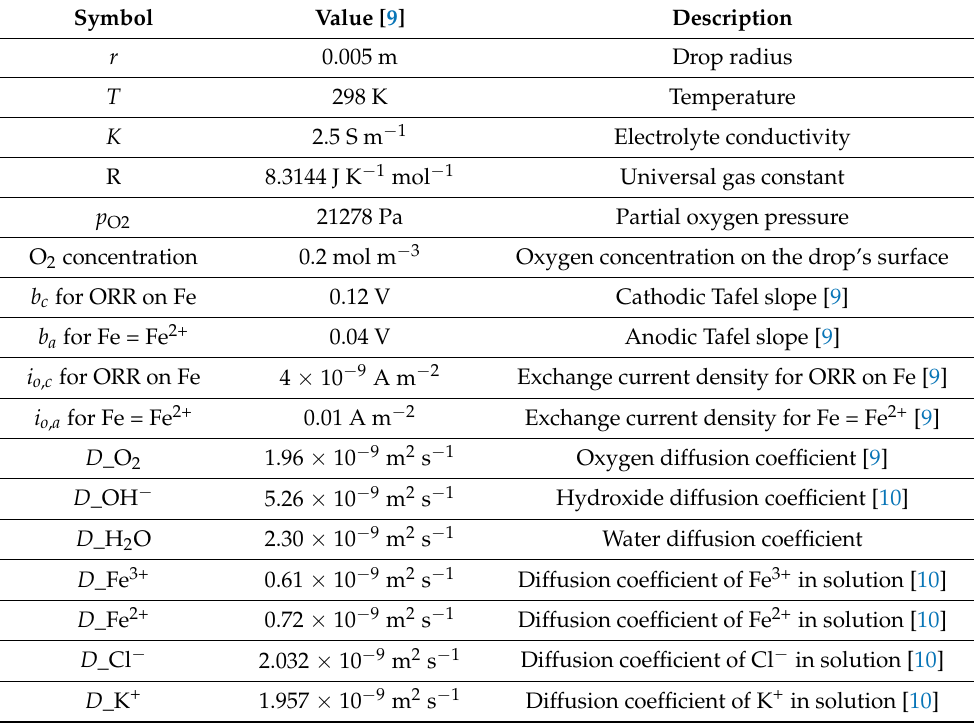
Table 1. Parameters and constants used for the